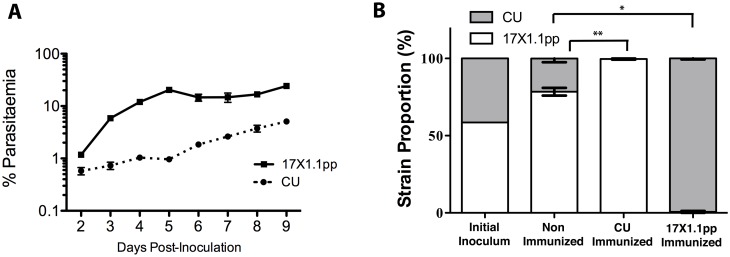
Pure strain growth rates.(A) Growth rate of Plasmodium yoelii strains 17X1.1pp and CU in CBA mice inoculated with 1 × 106 iRBCs on Day 0. Error bars indicate the standard error of the mean for three mice per group. (B) The relative proportions of CU and 17X1.1pp were measured by Q-RT-PCR targeting the polymorphic msp1 locus at Day 4 post-inoculation with a mixed inoculum containing approximately equal proportions of both strains in naïve mice and mice immunized with one of the two strains. Error bars show the standard error of the mean of five mice per group. *p<0.05, Wilcoxon rank sum test, W = 25, p = 0.0119, n = 5; ** p<0.01, Wilcoxon rank sum test, W = 25, p = 0.0075, n = 5